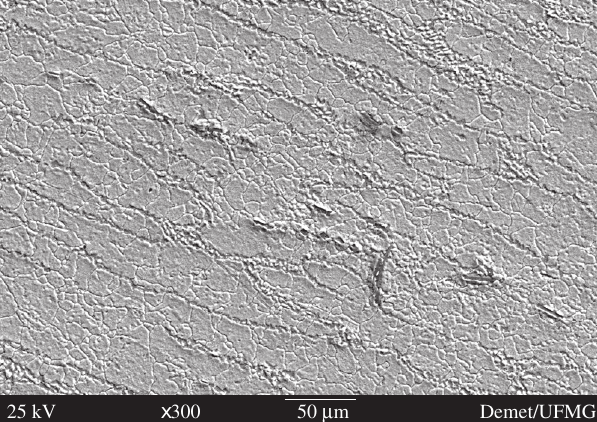
Figure 5. SEM image of Pb-4%Sb alloy processed by one pass of ECAP (longitudinal section).